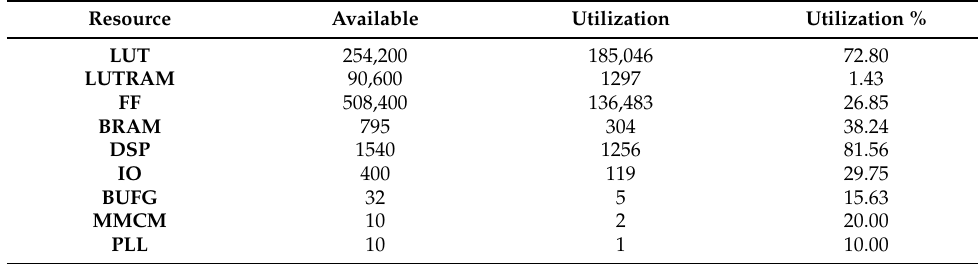
Table 2. NN engine resource consumption of the